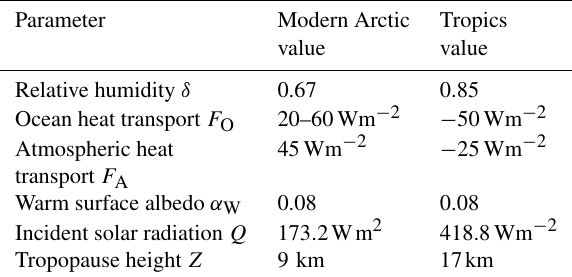
Table 2. Summary of parameters used in the tropics EBM. Relative humidity δ is higher in the tropics than the Arctic, and the forcings F O and F A are negative instead of positive. The insolation Q is as determined by McGehee and Lehman (2012). Tropopause height Z is from Kishore et al. (2006). Parameters not listed here are as in Table 1. Forcing parameter values for the tropics